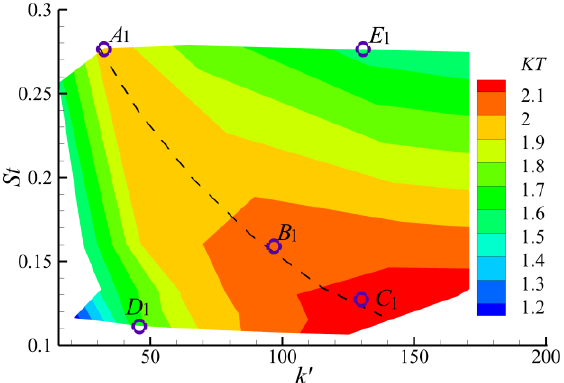
Figure 18. Thrust coefficient distribution diagram of bow foil with different S t numbers and different spring stiffness.